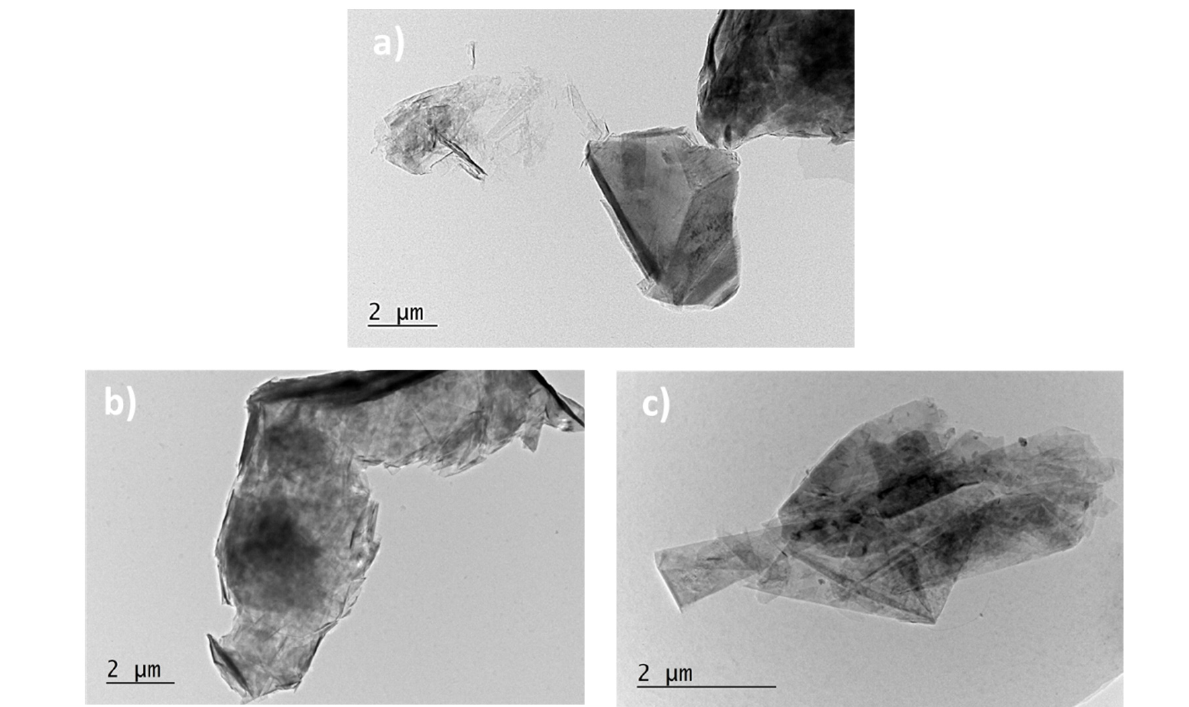
Figure 5. TEM images regarding the graphene nanoplatelets adopted in the present study as rein- forcement for the PLA matric are reported in ( a – c ).